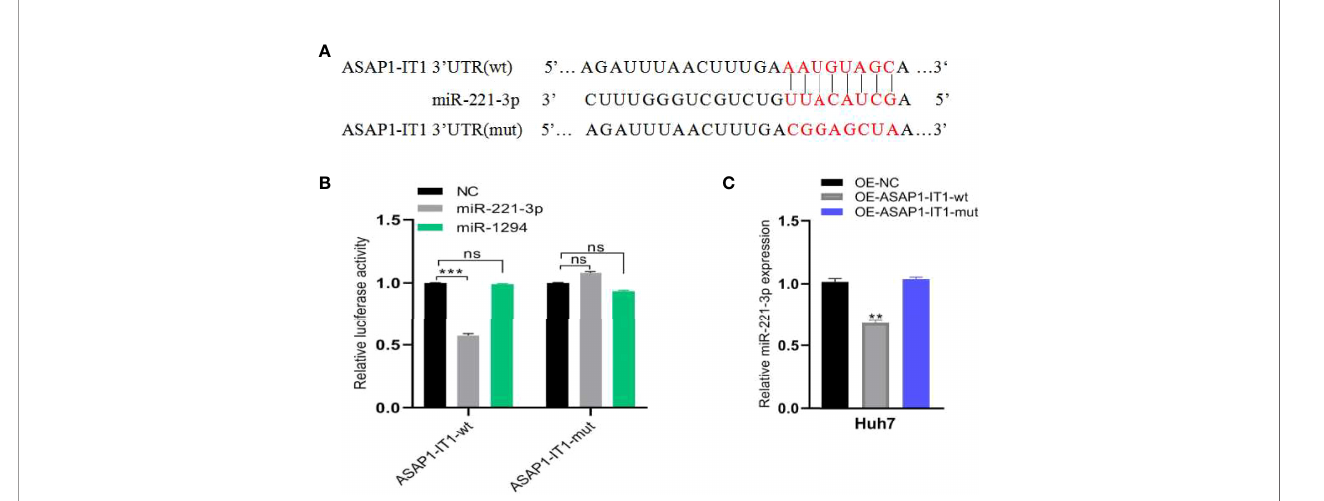
FIGURE 6 | ASAP1-IT1 functions as a sponge for miR-221-3P. (A) Schematic representation of wild-type (wt) and mutant (mut) ASAP1-IT1 with mutations to the binding sites for miR-221-3p. (B) Luciferase activity of wt or mut ASAP1-IT1 in HEK293T cells after co-transfection with miR-221-3p mimics or NC mimics. (C) qRT-PCR analysis of relative expression levels of miR-221-3p in OE-NC, OE-ASAP1-IT1-wt, or OE-ASAP1-IT1-mut transfected Huh7 cells. All experiments were performed in triplicate and each was repeated three times. n.s. Not statistically signi fi cant; ** p < 0.01, *** p <